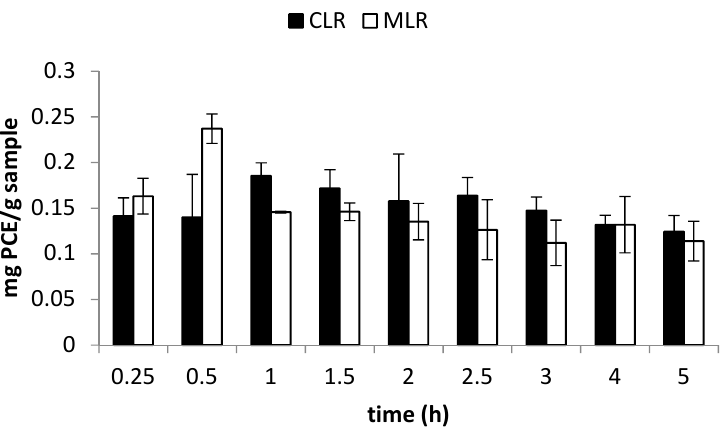
Figure 3. Effect of extraction time on total flavonoid content (TFC).